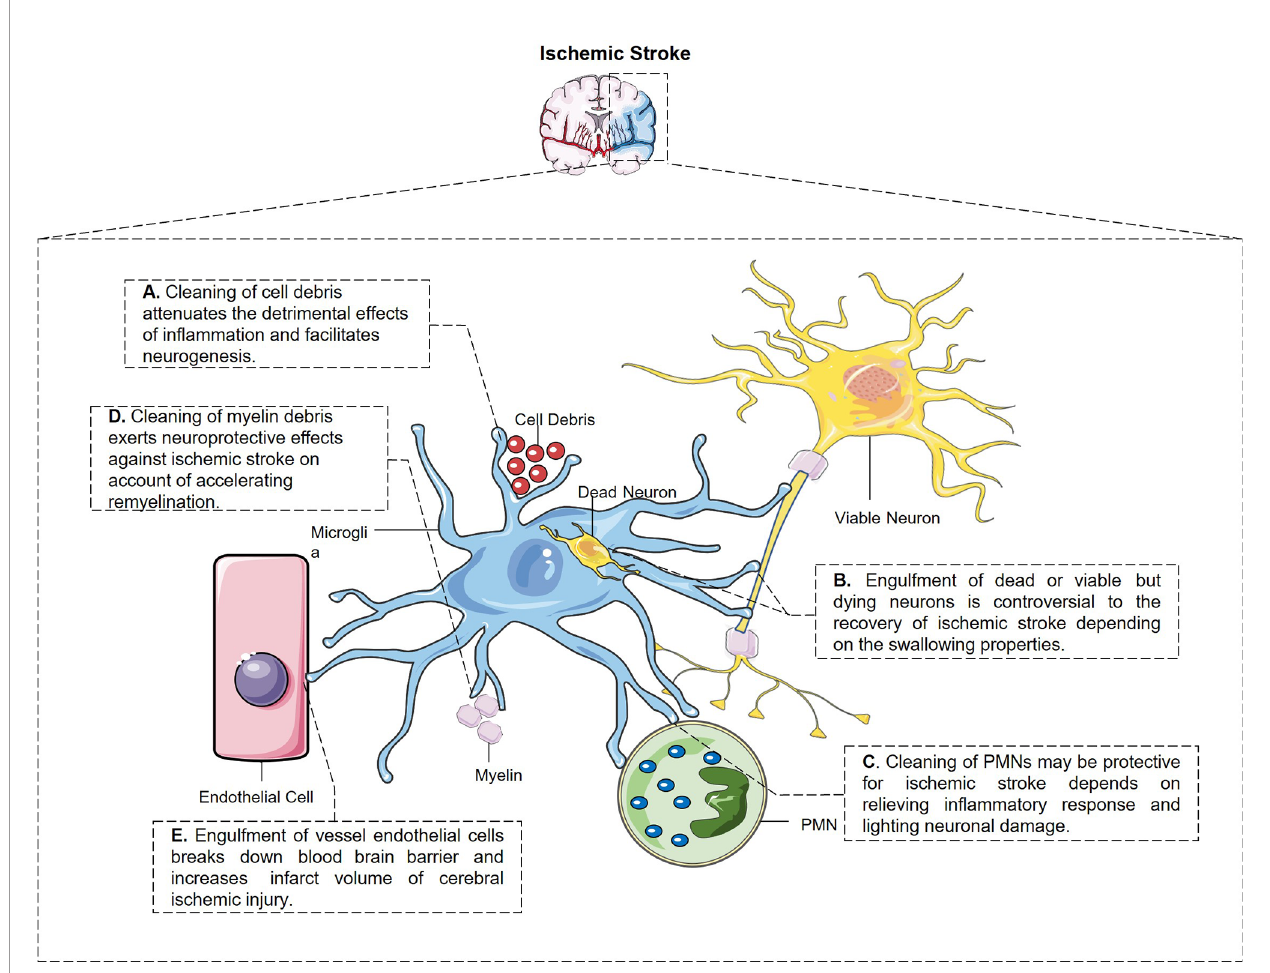
FIGURE 1 | The engulfment properties of microglia and its potential pathological outcome after ischemic stroke. (A) Microglia have the constant ability to clear cell debris, which attenuates the detrimental effects of in fl ammation and facilitates neurogenesis. (B) Microglia engulf dead and also stressed but viable neurons after stroke through different signal pathways, which is controversial to the stroke outcome. (C) Microglia swallow not only living but also dying PMNs and relieves in fl ammatory response and neuronal damage from every aspect. (D) Microglia swallow myelin debris in MCAO mice which may be protective for ischemic stroke in a way of accelerating remyelination and restoring white matter damage. (E) Perivascular microglia eat up endothelial cells after cerebral ischemic injury which breaks down blood – brain barrier and enlarged infarct